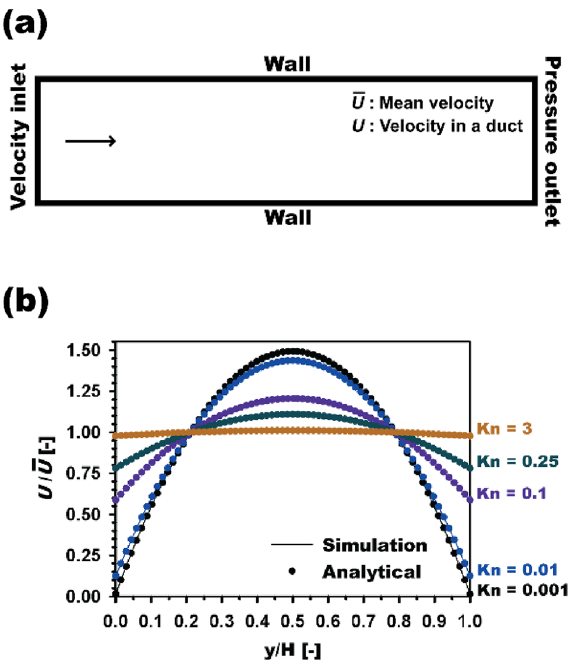
Figure 2. ( a ) Calculation domain with boundary conditions for a 2-D duct flow and ( b ) comparison of velocity profiles at different Kn ranging from 0.001 to